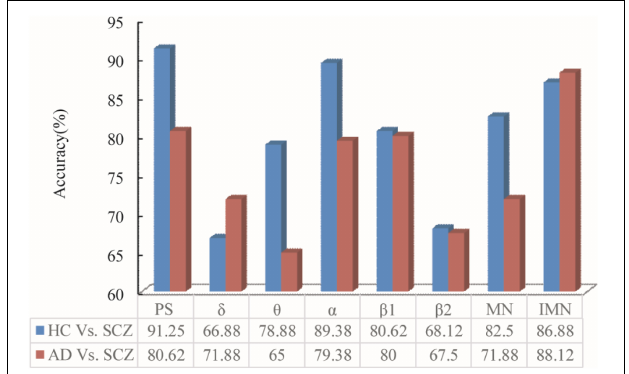
FIGURE 5 | PS, δ , θ , α , β 1, β 2, MN, and IMN are used to classify by ELTS between the data of HC and SC. To verify the feasibility and generalizability, it was also applied to the data of AD patients and